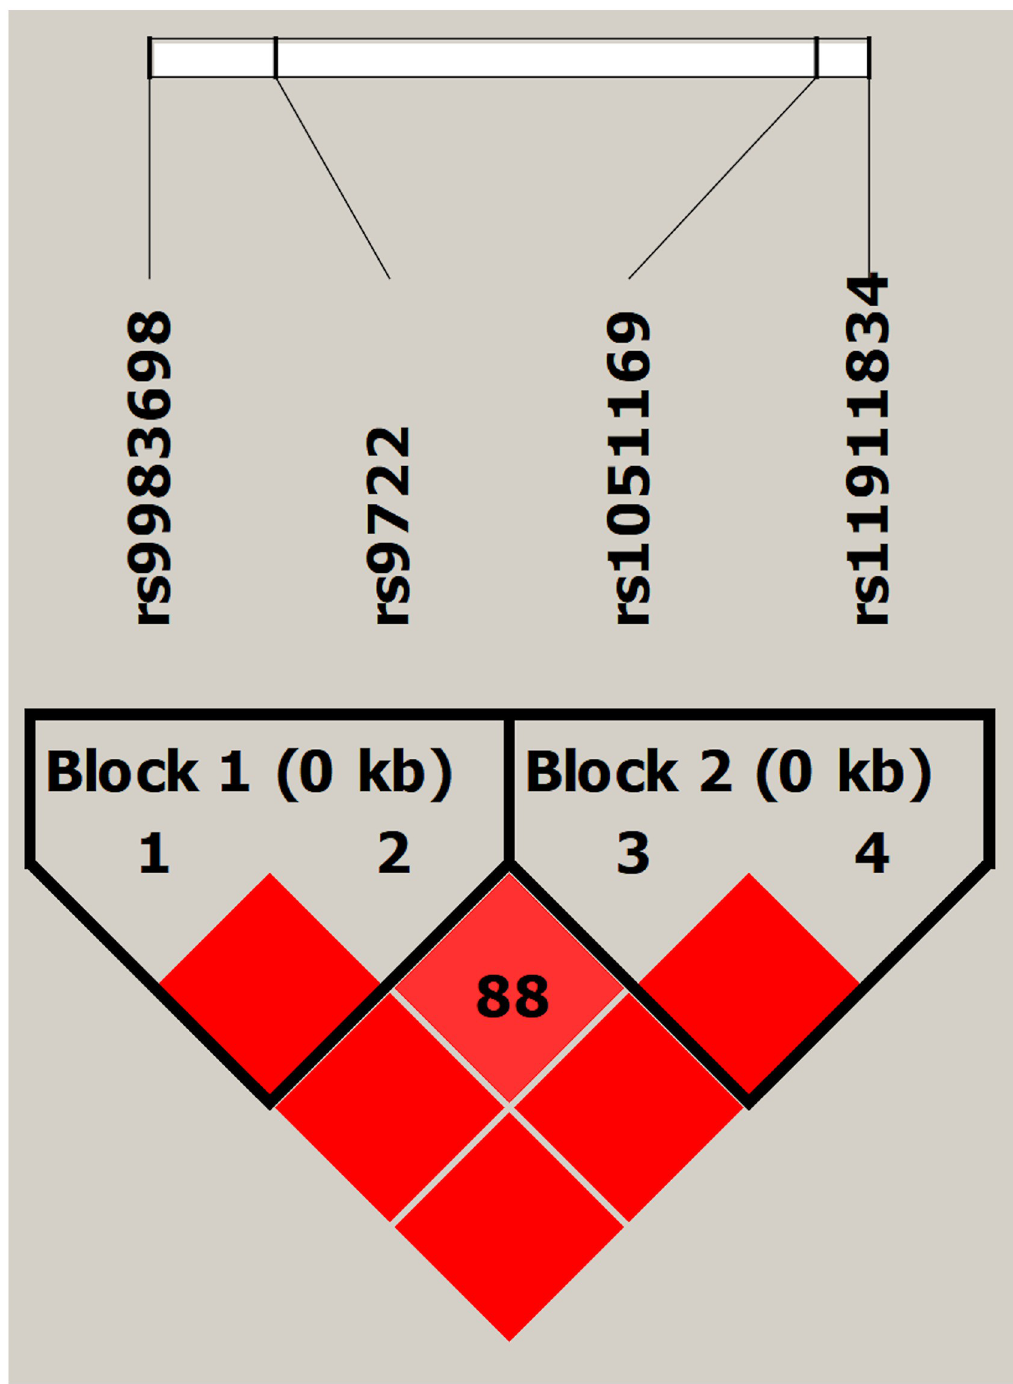
Fig 1. Linkage disequilibrium plot for S100B SNPs.